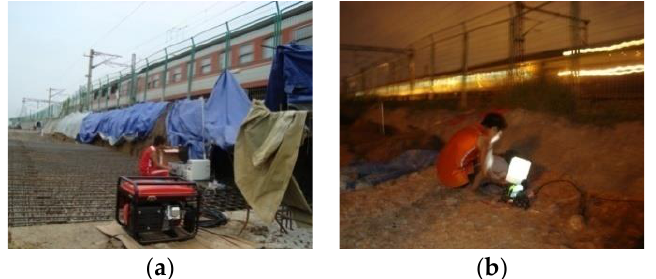
Figure 2. Field dynamic testing. ( a ) is data acquisition; ( b ) is data processing.